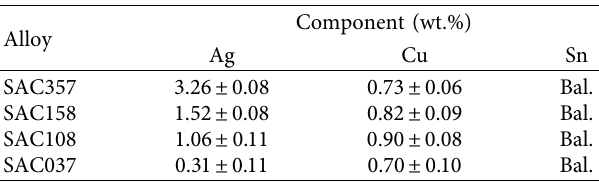
Figure 3: Final geometry of solder joints: an optical image (a) and FEM model (b). Table 1: Measured concentrations of Ag, Cu, and Sn in the solder alloys.